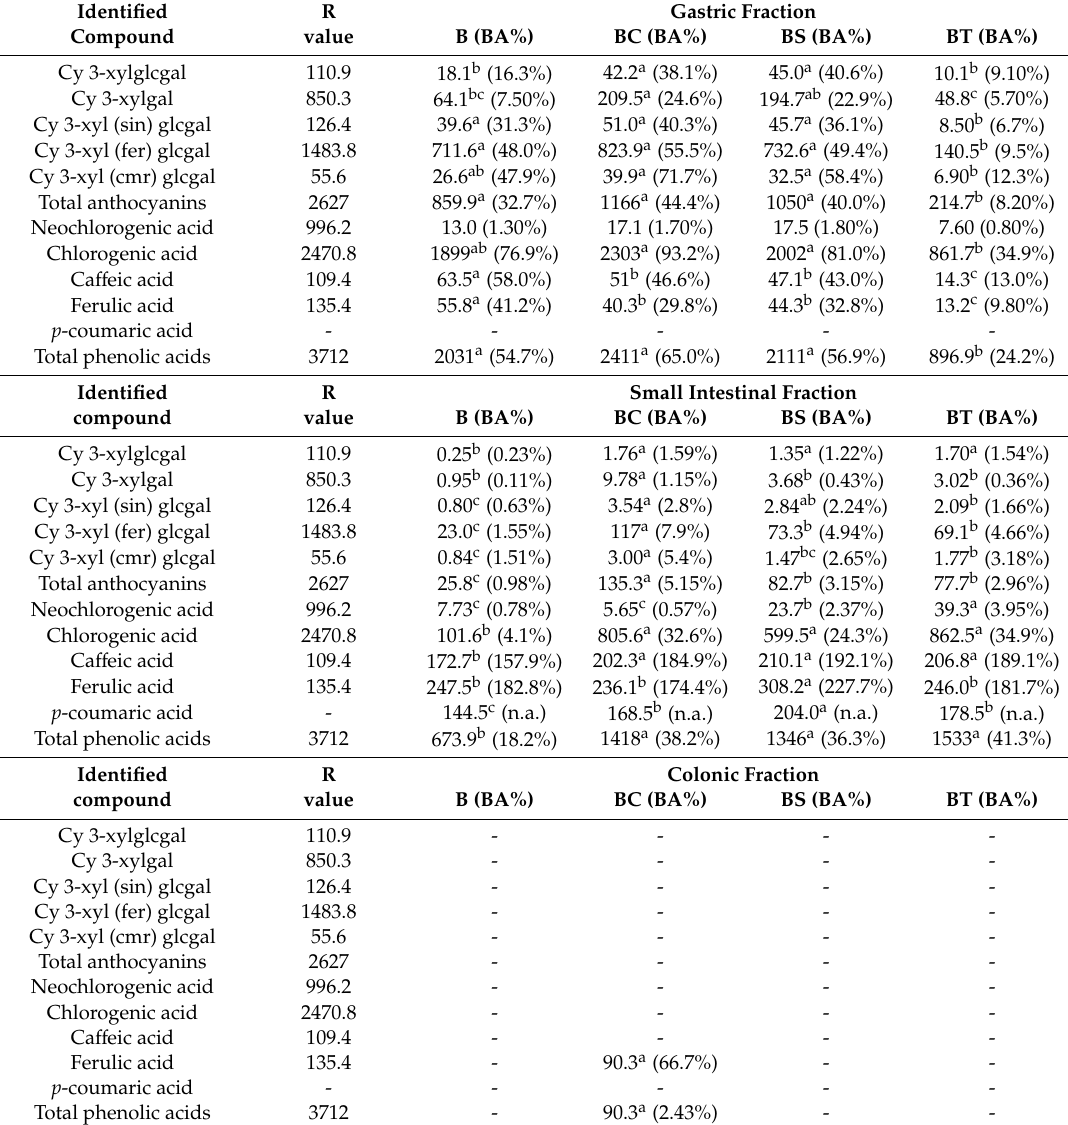
Table 2. Quantity of individual polyphenols in the black carrot and oil combinations at di ff erent digestive compartments (ug / g black carrot